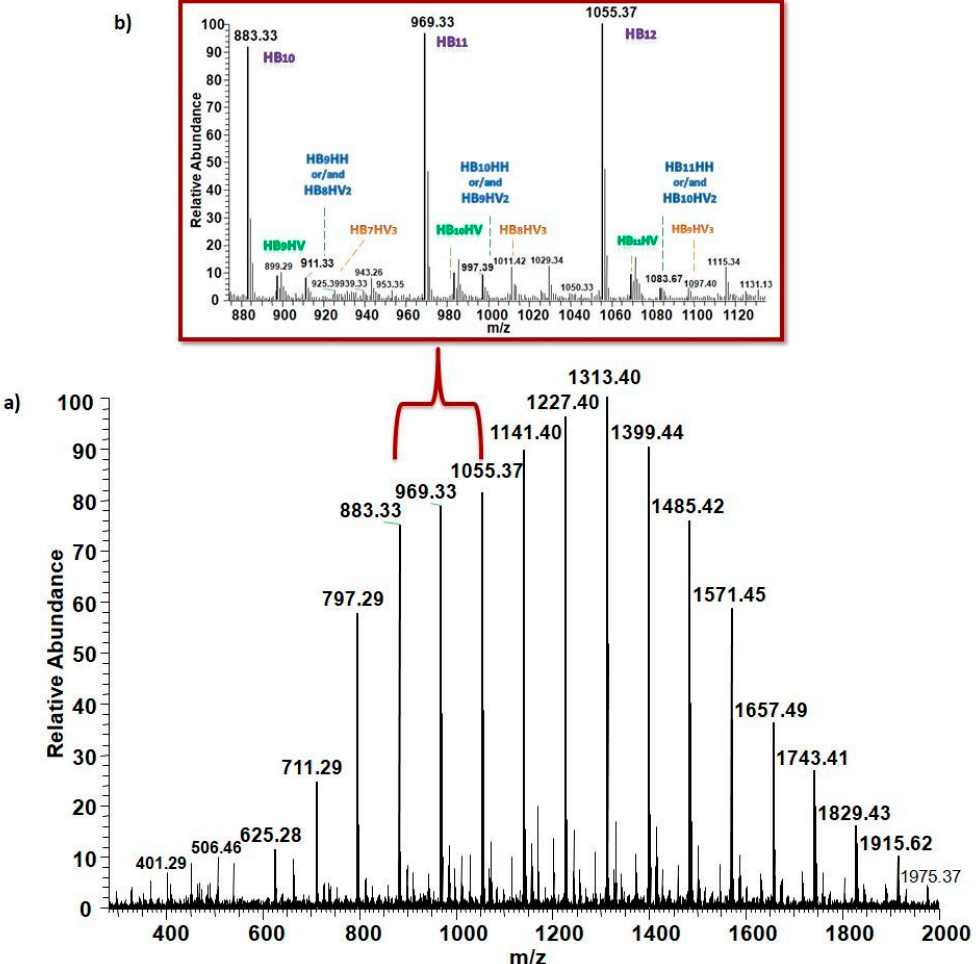
Figure7. ( a )TheESI-MS(positive–ionmode)ofPHAoligomersformedafterpartialthermaldegradation Figure 7. ( a ) The ESI-MS (positive–ion mode) of PHA oligomers formed after partial thermal of sample PHA-PP-0; ( b ) spectral expansion in the mass range at m / z 870–1140. The sample was degradation of sample PHA-PP-0; ( b ) spectral expansion in the mass range at m/z 870–1140. The analyzed in a chloroform / methanol (1:1; v / v ) sample was analyzed in a chloroform/methanol (1:1; v/v ) system.